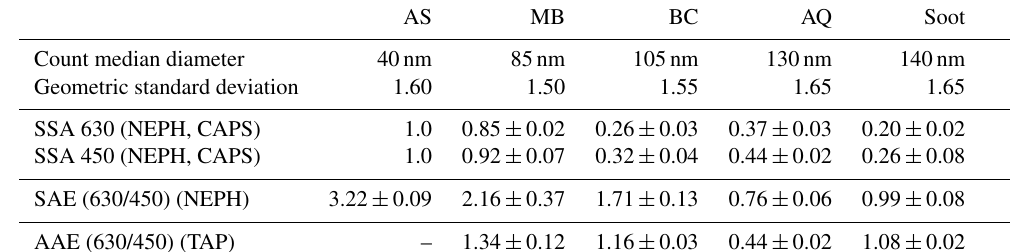
Table 3. Overview of the measured intensive optical properties of the pure aerosol types.